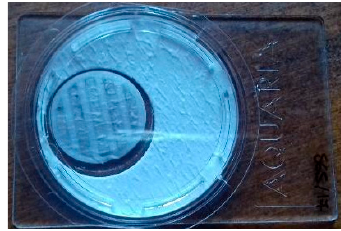
Figure 4. Example of filter sampled at University of Florence for insoluble EC/OC/TC measurements in melted